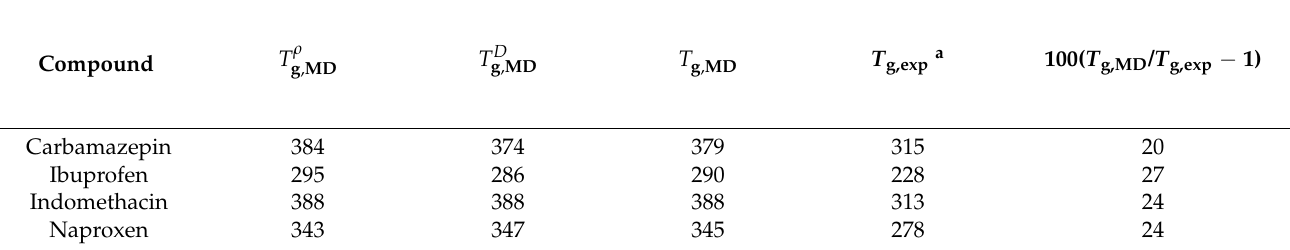
Table 4. Comparison of simulated (density-derived T ρ ( T g,exp ) glass transition temperatures (given in